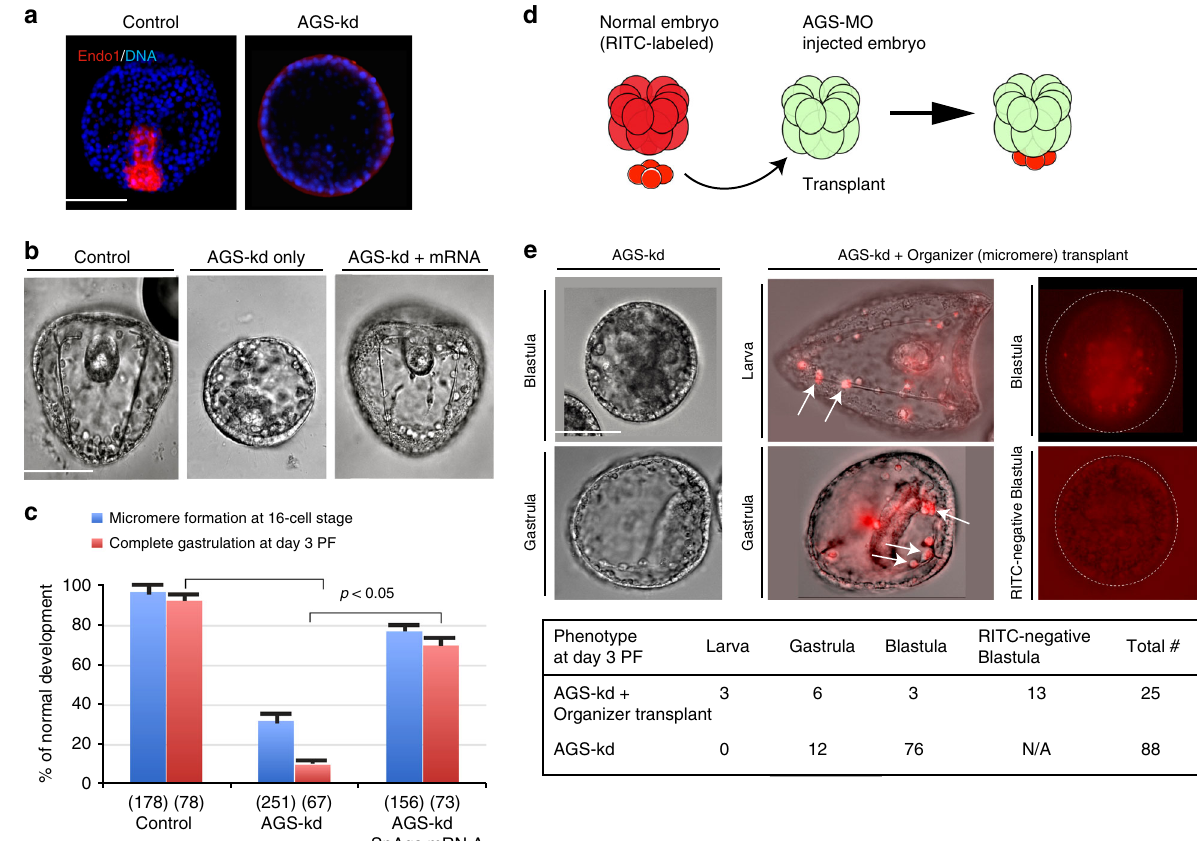
Fig. 4 AGS is important for micromere ’ s function as organizers. a An endoderm marker, Endo1 (red) was highly expressed in the archenteron of gastrula (Day 2 PF) in the normal embryo, whereas no archenteron or Endo1 expression was found in AGS-MO injected embryos even with lower dose (1 mM). DNA, blue. The representative phenotypes of 85% or larger in each population are shown ( n = 50 or larger). b , c AGS-MO (1 mM stock) injection resulted in embryonic death after blastula stage (AGS-kd only) yet co-injection of SpAgs-mRNA (0.25 μ g/ μ l) that is insensitive to AGS-MO rescued the knockdown phenotype (AGS-kd + mRNA) to the level of Control embryos (1 mM Nanos-MO stock). The graph in c demonstrates % of embryos that formed micromeres at 16-cell stage (blue bars) and completed gastrulation at Day 3 PF (red bars). () indicates the number of embryos examined. Each experiment was performed at least three independent times. The statistical signi fi cance obtained by one-way Nova is indicated as p -value. Scale bars = 50 μ m. d , e AGS is essential for speci fi cation of micromeres as a developmental organizer. Diagram indicates the experimental procedure of micromere-transplant. Over 86% of embryos injected with AGS-MO (2 mM stock) remained as blastula and failed in gastrulation (AGS-kd). On the other hand, when these host embryos received wild-type micromeres (AGS-kd + Organizer (micromere) transplant), the RITC-labeled micromeres rescued the developmental defects, and differentiated normally into skeletogenic and coelomic pouch cells (red, arrows). In some cases, however, the transplanted cells entered the blastocoel and the embryos failed in gastrulation (a dashed circle in Blastula). Table in e indicates the number of embryos that successfully developed to each developmental stage (Larva, Gastrula, or Blastula), or that showed no detection of RITC-labeled transplanted cells (a dashed circle in RITC-negative Blastula), or that were observed in total (Total #). Scale bars = 50 μ